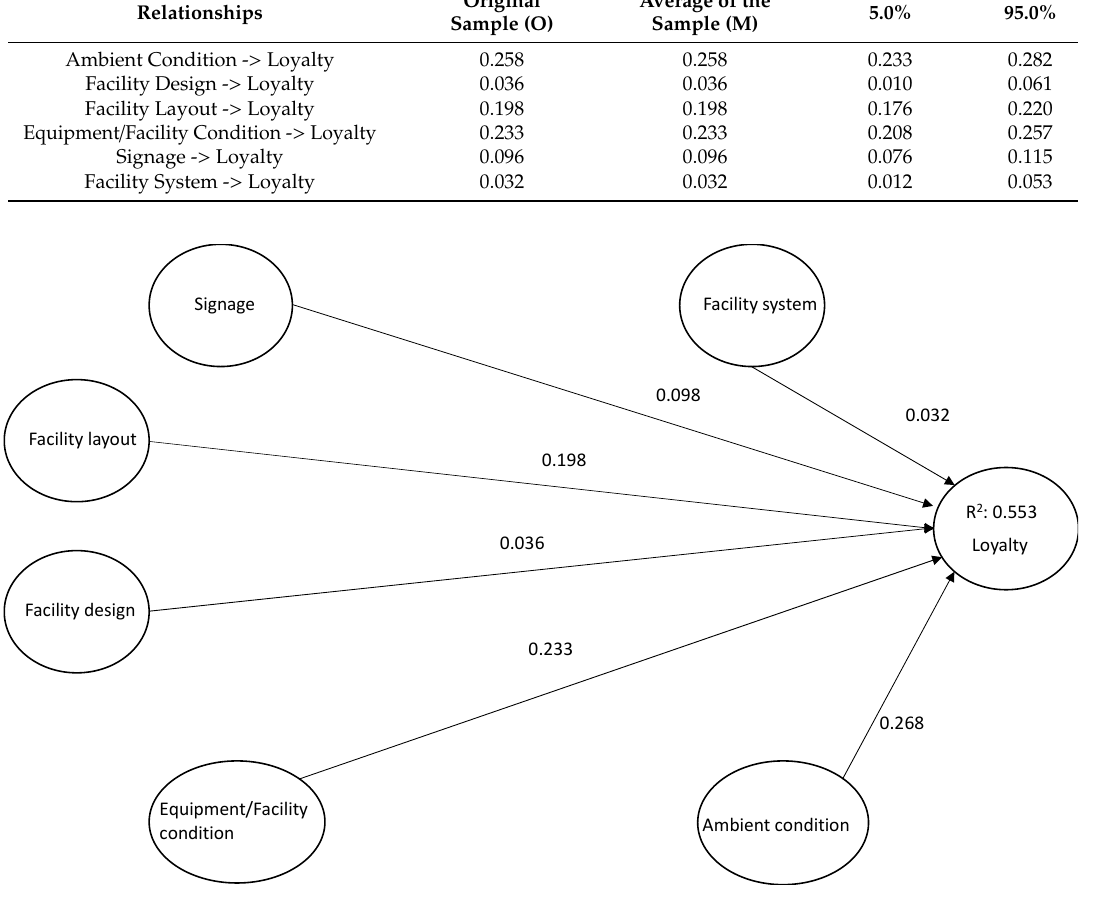
Figure 2. Relationship between constructs.